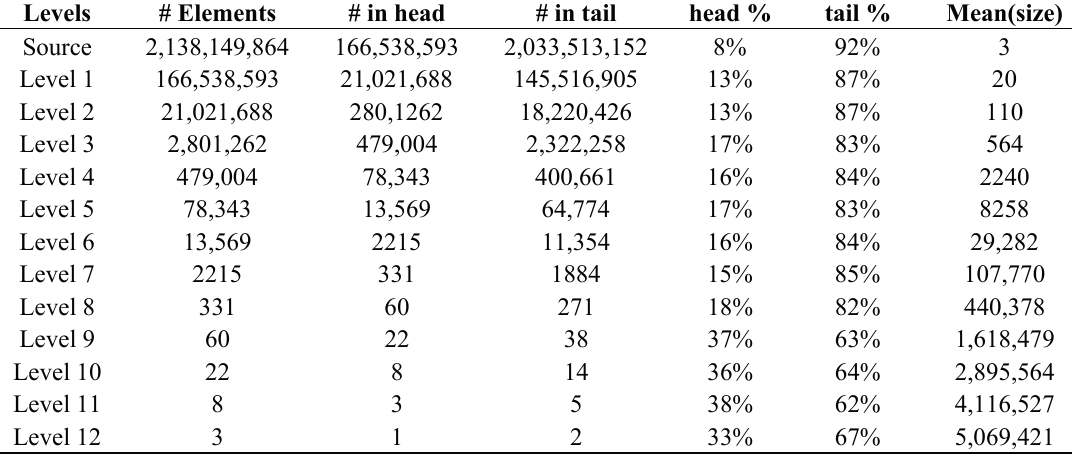
Table A3. Head/tail breaks statistics for each element